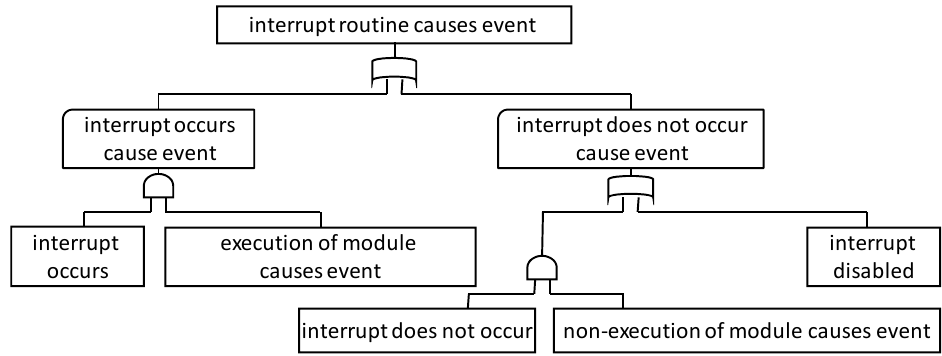
Figure 8. FTT for Figure 8. FTT for interrupt.